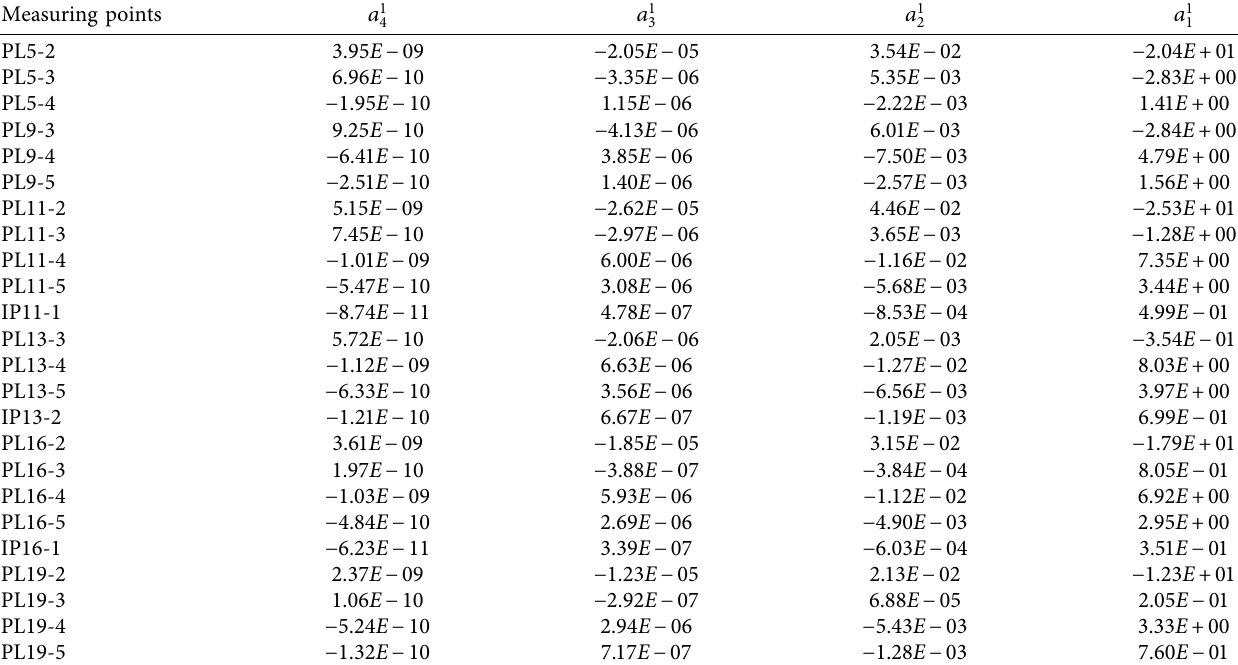
Table 1: Coefficients a 1 i fitted by the simulation results of the finite element model. Measuring